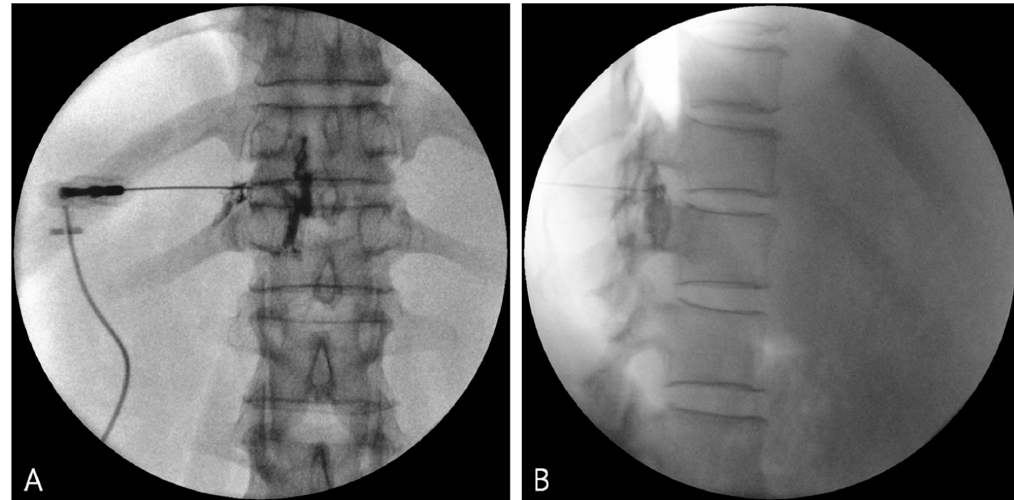
Figure 1. Fluoroscopic images of TFEI. ( A ) Anteroposterior (AP) view. ( B ) Lateral view. TFEI: Transforaminal epidural injection.